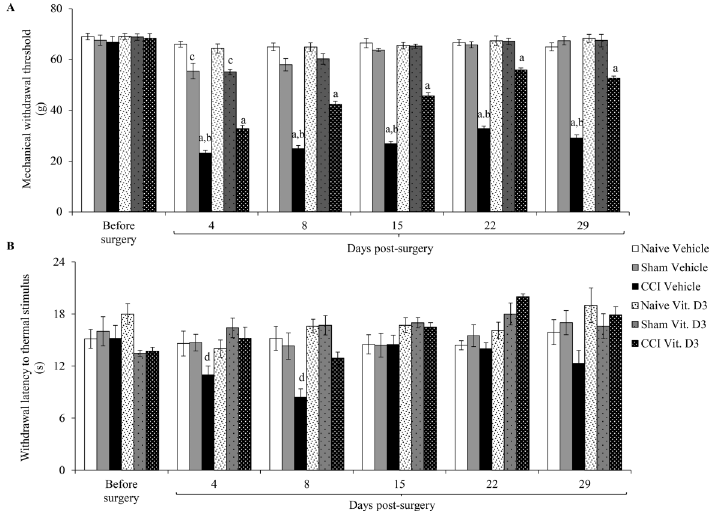
Figure 2. Assessment of mechanical withdrawal threshold ( A ) and withdrawal latency to thermal stimulus ( B ) in rats with chronic constriction injury (CCI) of the sciatic nerve that received vitamin D 3 (Vit. D3) daily per gavage (500 IU/kg per day) or vehicle for 28 days after surgery. The tests were carried out before surgery and at 4, 8, 15, 22, and 29 days post-surgery. Data are reported as means ± SE (n=6/group). a P o 0.05 compared to before surgery and naive and sham groups; b P o 0.05 compared to vitamin-treated CCI rats at the same measurement time; c P o 0.05 compared to before surgery and naive groups; d P o 0.05 compared to before surgery (repeated- measures ANOVA followed by Tukey ’ s post hoc test). For Sham rats, all surgical procedures involved in the CCI were used except the